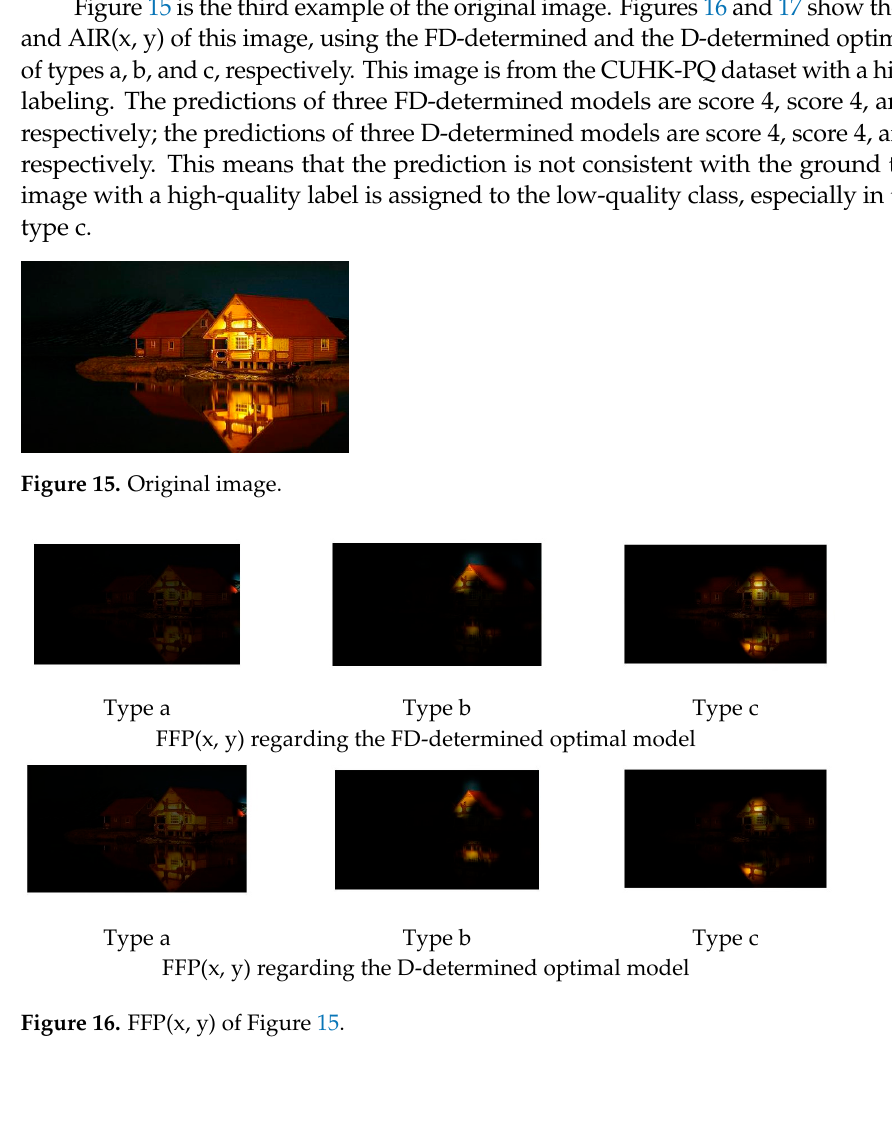
Figure 16. FFP(x, y) regarding the D-determined optimal model